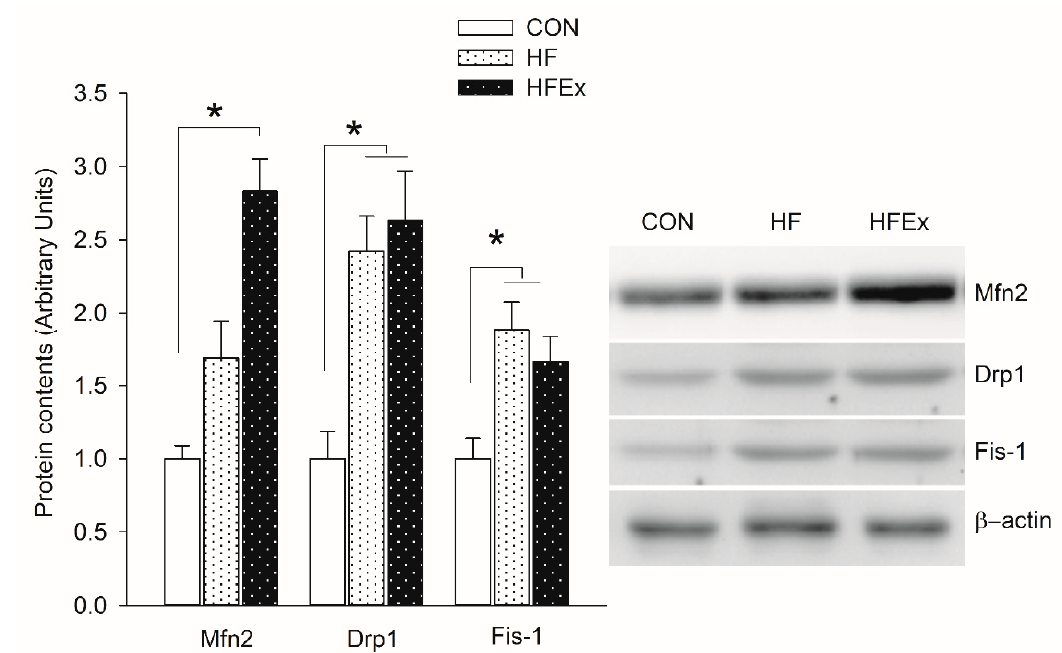
Figure 4. Expression levels of protein involved in mitochondrial dynamic in the EDL muscle. Data are presented as means ± SEM. Data was analyzed by one-way ANOVA. * p < 0.05 vs. CON. CON, control; HF, HFD intake; HFEx, high-fat diet with low-intensity endurance exercise; EDL, extensor digitorum longus.